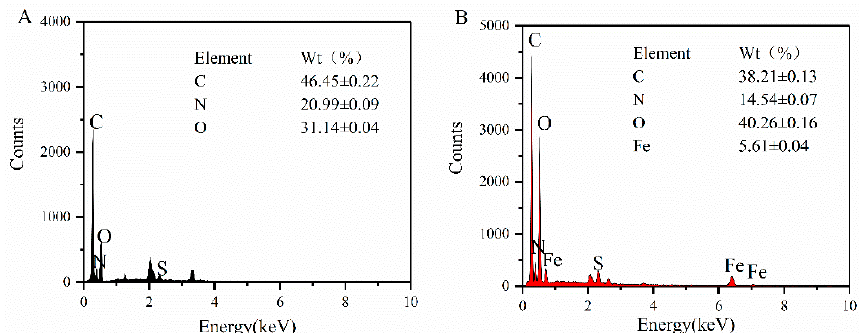
Figure 4. Elemental composition analysis of the WP ( A ) and WP-Fe chelate ( B ).